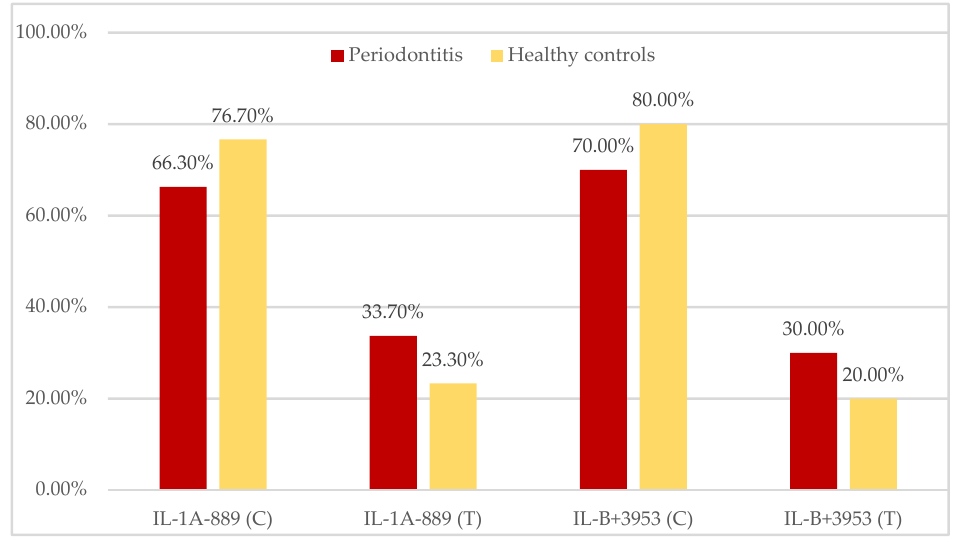
Figure 1. There were no significant differences in the distribution of either IL-1 allele between both groups.